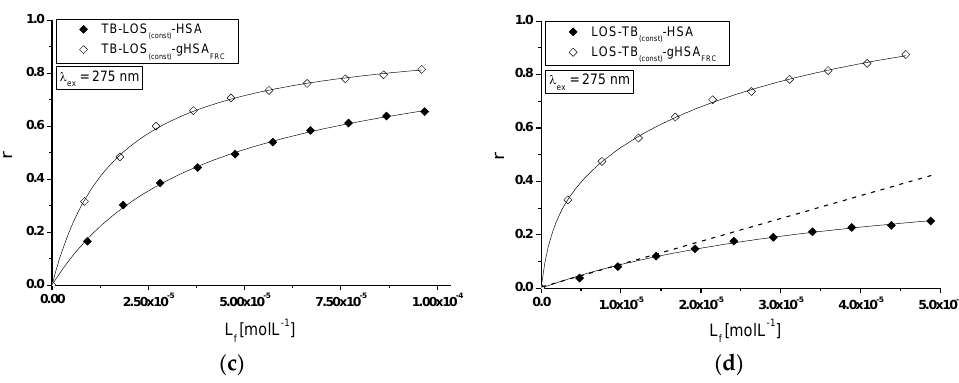
Figure 15. Binding isotherms of HSA and gHSA FRC at 5 × 10 −6 mol∙L −1 concentration with TB at 1 × 10 −5 –1 × 10 −4 mol∙L −1 and LOS at 5 × 10 −6 –5 × 10 −5 mol∙L −1 concentrations in the binary ( a ) TB-HSA, TB-gHSA FRC , ( b ) LOS-HSA, LOS-gHSA FRC and ternary systems, ( c ) TB-LOS (const) -HSA, TB-LOS (const) -gHSA FRC with LOS at 5 × 10 −6 mol∙L −1 concentration, ( d ) LOS-TB (const) -HSA, LOS-TB (const) -gHSA FRC with TB at 5 × 10 −6 mol∙L −1 concentration, λ ex = 275 nm; the error bars are smaller than the symbols. It means that non-specific binding sites on a HSA and gHSA FRC surface, in the neighborhood of excited tyrosyl residues or/and formation of TB-HSA, TB-gHSA FRC , LOS-HSA, LOS-gHSA FRC and TB- LOS (const) -HSA, TB-LOS (const) -gHSA FRC , LOS-TB (const) -HSA, LOS-TB (const) -gHSA FRC complexes in hydrophobic pocket of albumin takes place.